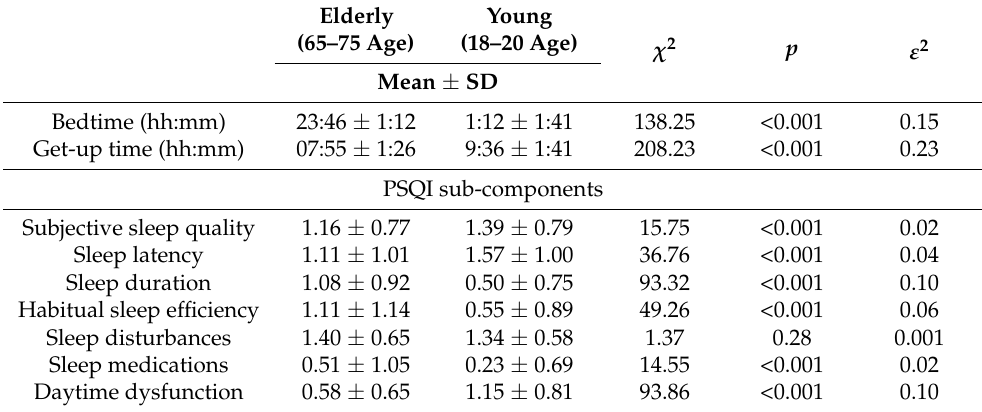
Figure 1. Sleep quality (PSQI), severity of insomnia symptoms (ISI), and inclination to Morningness–Eveningness (MEQr) for elderly and young respondents during the COVID-19 lockdown. Center lines show the medians; box limits indicate the 25th and 75th percentiles; whiskers extend to 5th and 95th percentiles, dots represent outliers; crosses represent sample means. Significant differences of Kruskal–Wallis test between elderly (violet) and young (yellow) participants are indicated with asterisks (*** p < 0.001). Abbreviations: PSQI, Pittsburgh Sleep Quality Index; ISI, Insomnia Severity Index; MEQr, Morningness–Eveningness Questionnaire-reduced version; N.S., not significant. Table 1. Mean and standard deviation (SD) of the two groups (Elderly, Young), and the corre- sponding statistical comparisons (Kruskal–Wallis: χ 2 , p , ε 2 ), for bedtime, get-up time, and the PSQI